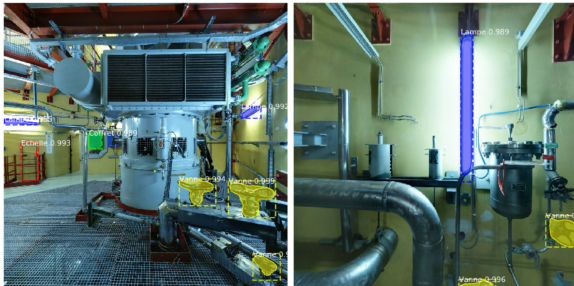
Figure 6. Two examples of things objects predicted by the Mask-RCNN. Class colors legend is given in appendix.